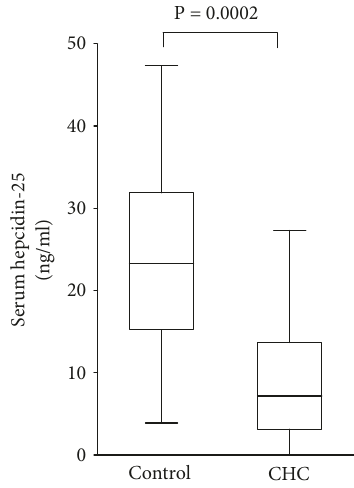
Figure 2: Serum hepcidin-25 levels were measured by LC-MS/MS. Median serum hepcidin-25 levels of control participants and CHC patients were 23.3ng/mL (range, 3.9-47.3) and 7.2ng/mL (range, 0-27.3). Serum hepcidin-25 levels in patients with CHC were significantly lower than in the control group ( P = 0.0002;Wilcoxon- Mann-Whitney U test). Bottom and top edges of the boxes are the 25th and 75th percentiles, respectively. Median values are shown by a line within the